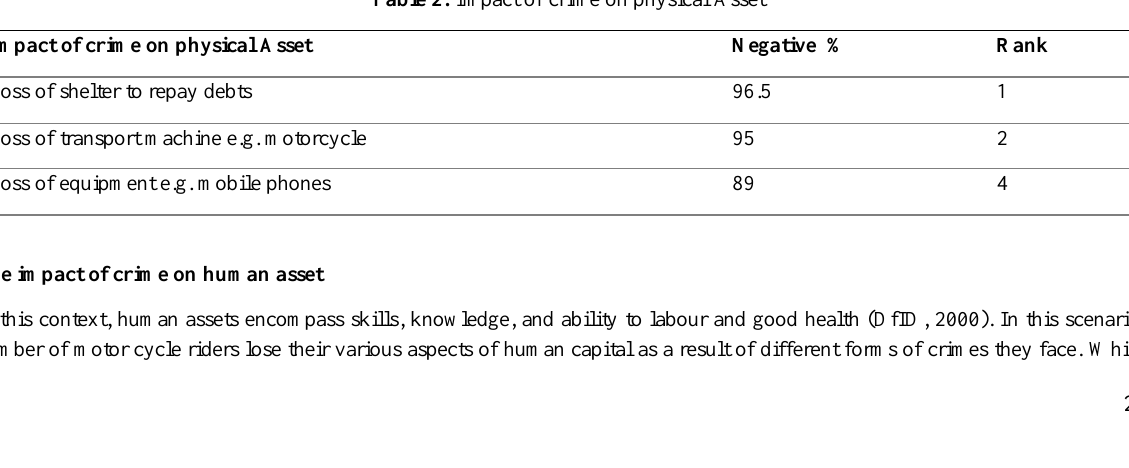
Table 2: Impact of crime on physical